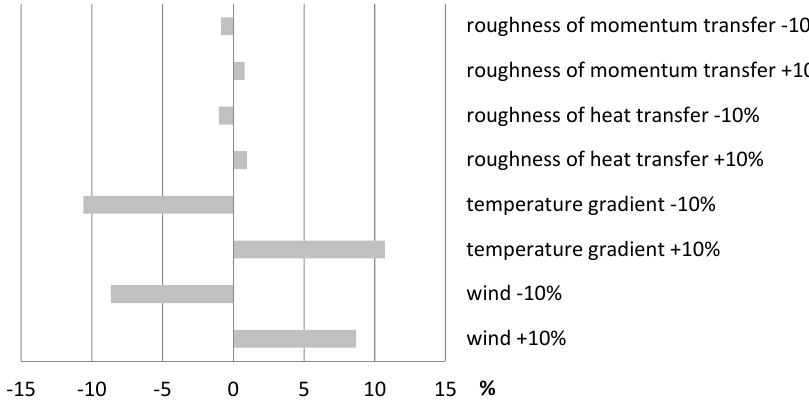
Figure 7. Sensitivity of sensible heat flux of AquaSEBS to the input parameters.